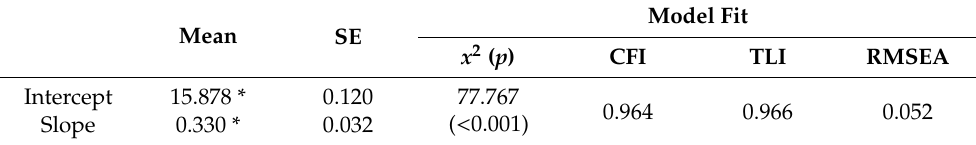
Table 2. Trajectory of depressive symptoms among multicultural adolescents (n = 1432).